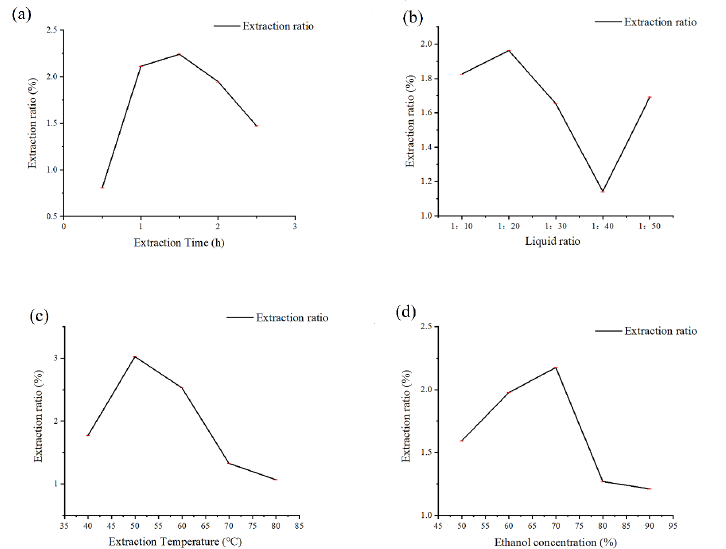
Figure 1. Analysis of single factor test results of extraction time, liquid ratio, extraction temperature, and ethanol concentration. ( a ): Effect of extraction time on the extraction rate of flavonoids from cotton flowers; ( b ): Influence of ratio of liquid to material on extraction rate of flavonoids from cot- ton flowers; ( c ): Influence of extraction temperature on extraction rate of flavonoids from cotton flowers; ( d ): Effect of ethanol concentration on extraction rate of flavonoids from cotton flowers.